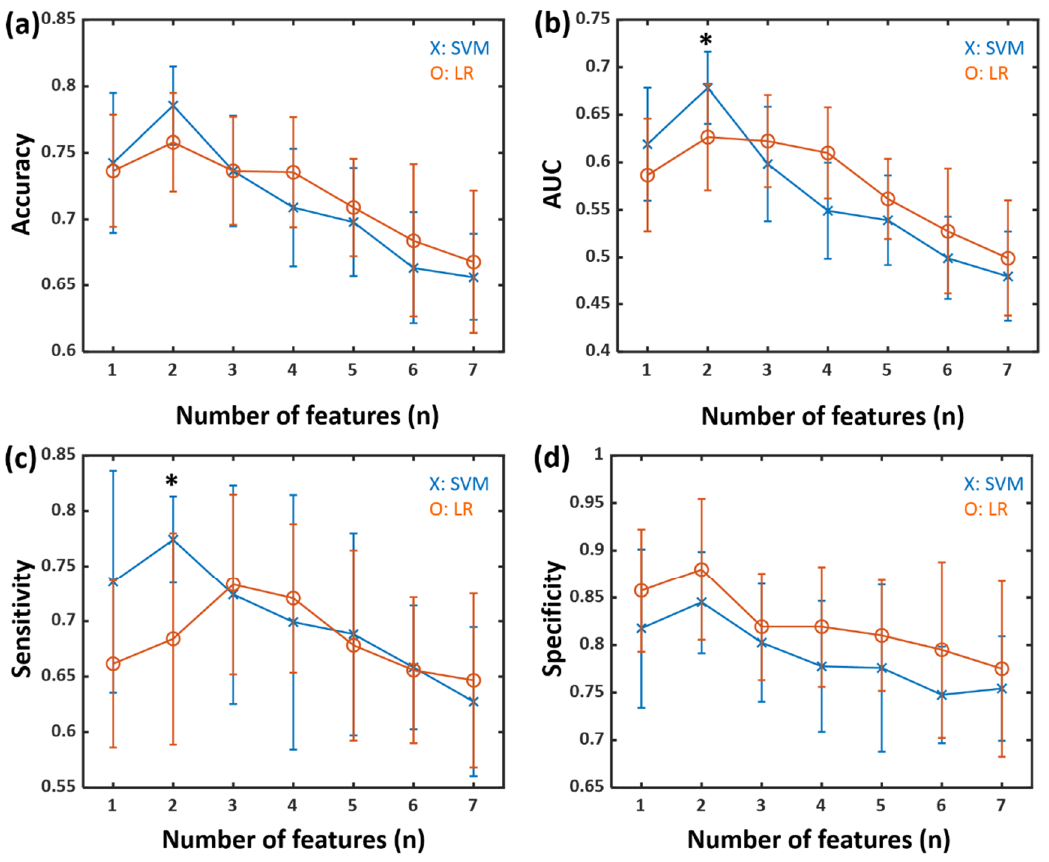
Figure 4. Performance of SVM and LR in classifying low and High Non-motor Symptoms Scale (NMSS) groups using backward elimination of features. The results are shown in regard to ( a ) accuracy, ( b ) area under the receiver operating curve (AUC), ( c ) sensitivity, and ( d ) specificity. The features were included as the training set from the region of interest with the highest F-score to the region of interest with the lowest F-score. Asterisk (*) shows significance ( p < 0.05). SVM = support vector machine. LR = logistic regression.